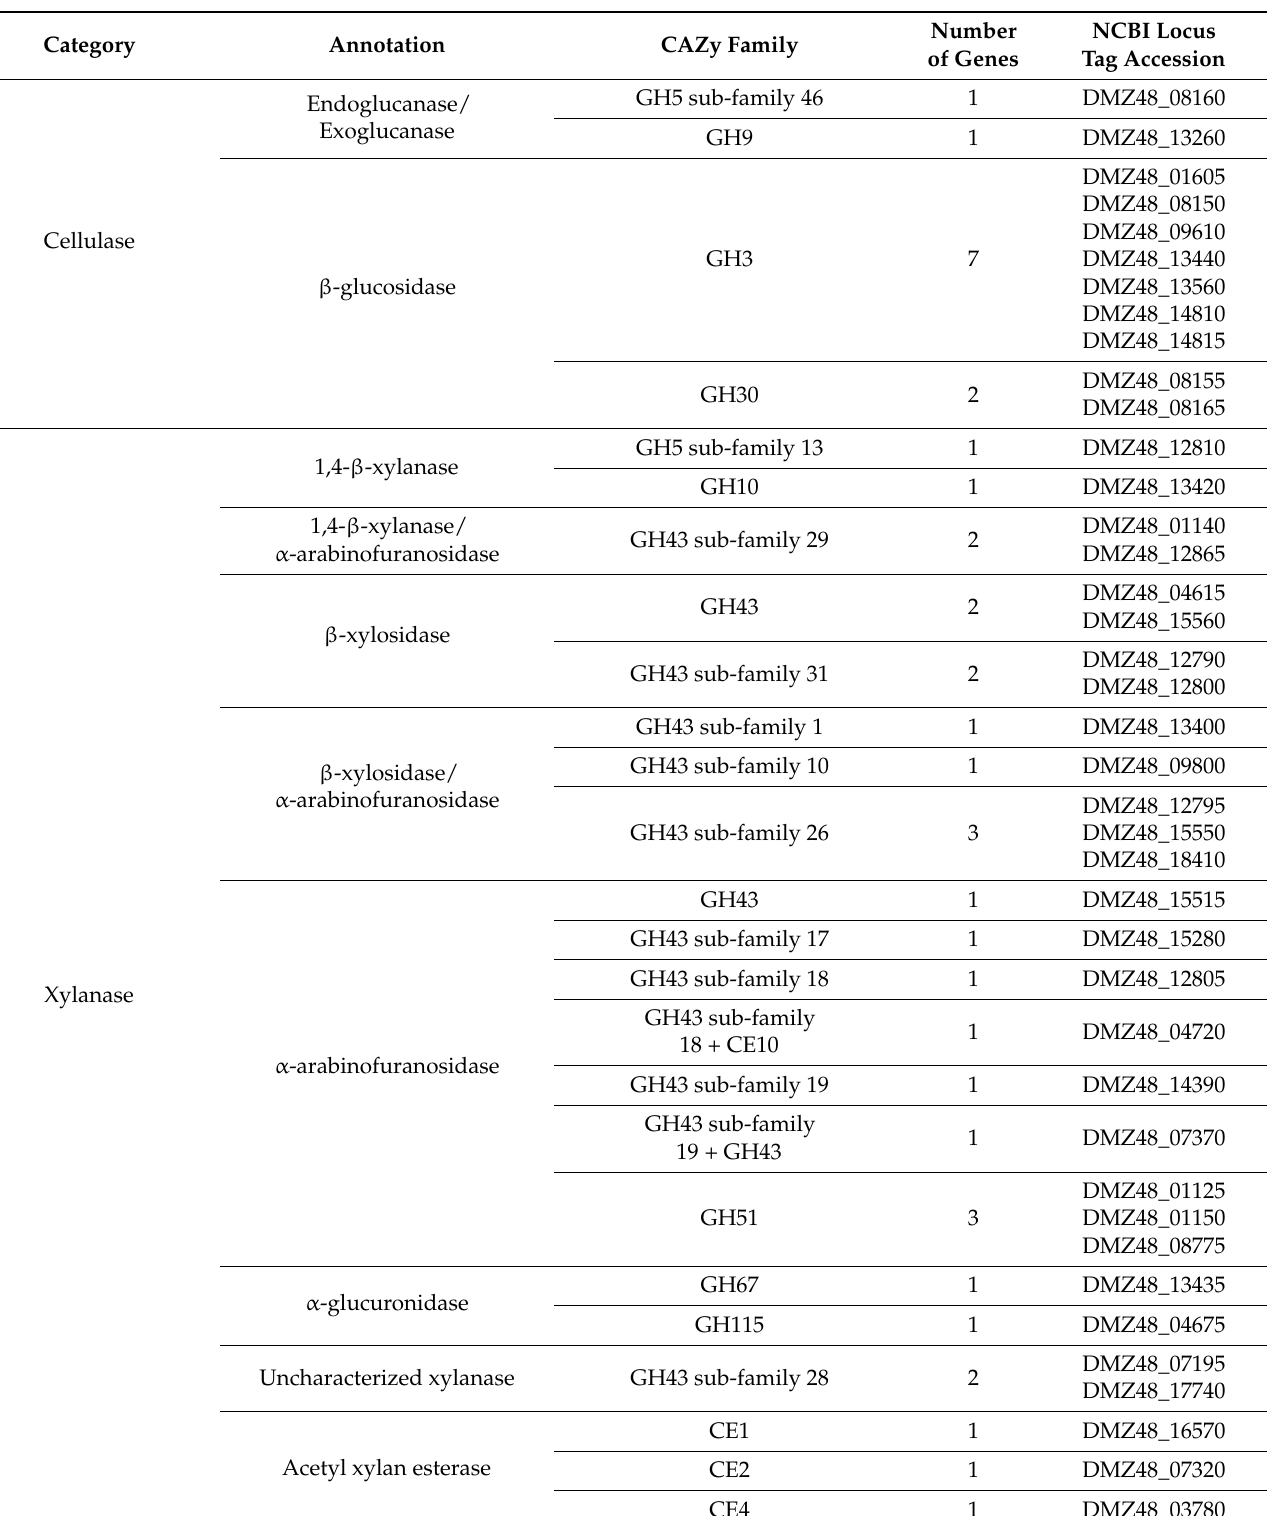
Table 2. List of putative lignocellulose degrading enzymes encoded in genome of R. solimangrovi